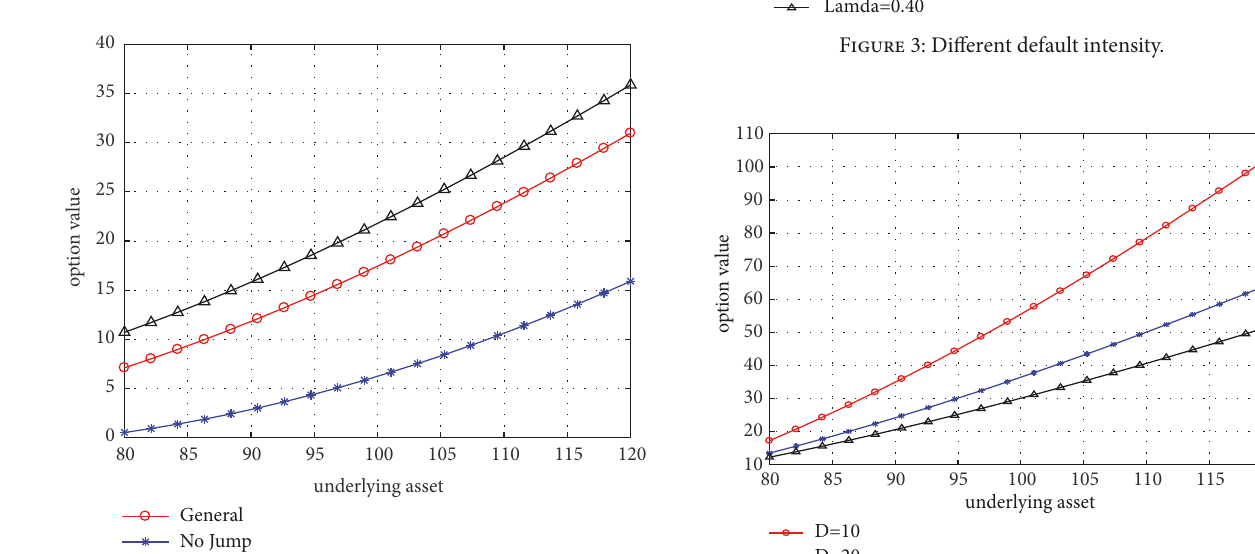
Figure 1: Change of option value.